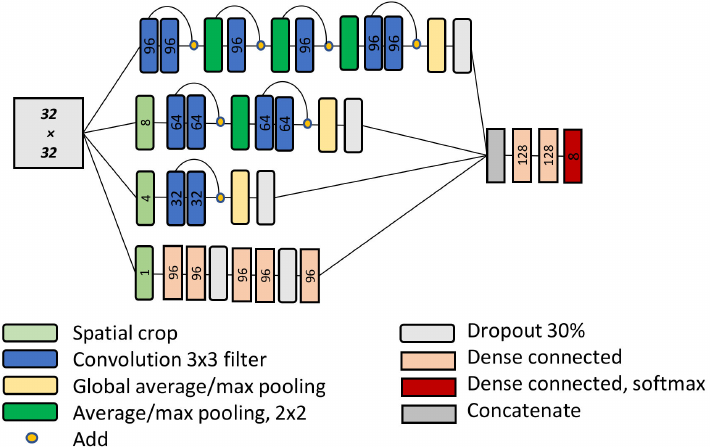
Figure 3. Schematic of the CNN used in the study. Input image size was 32 by 32 pixels shown as the large grey square. Numbers represent the number of features output from a convolution or dense layer, except for the cropping layers where the crop dimension is